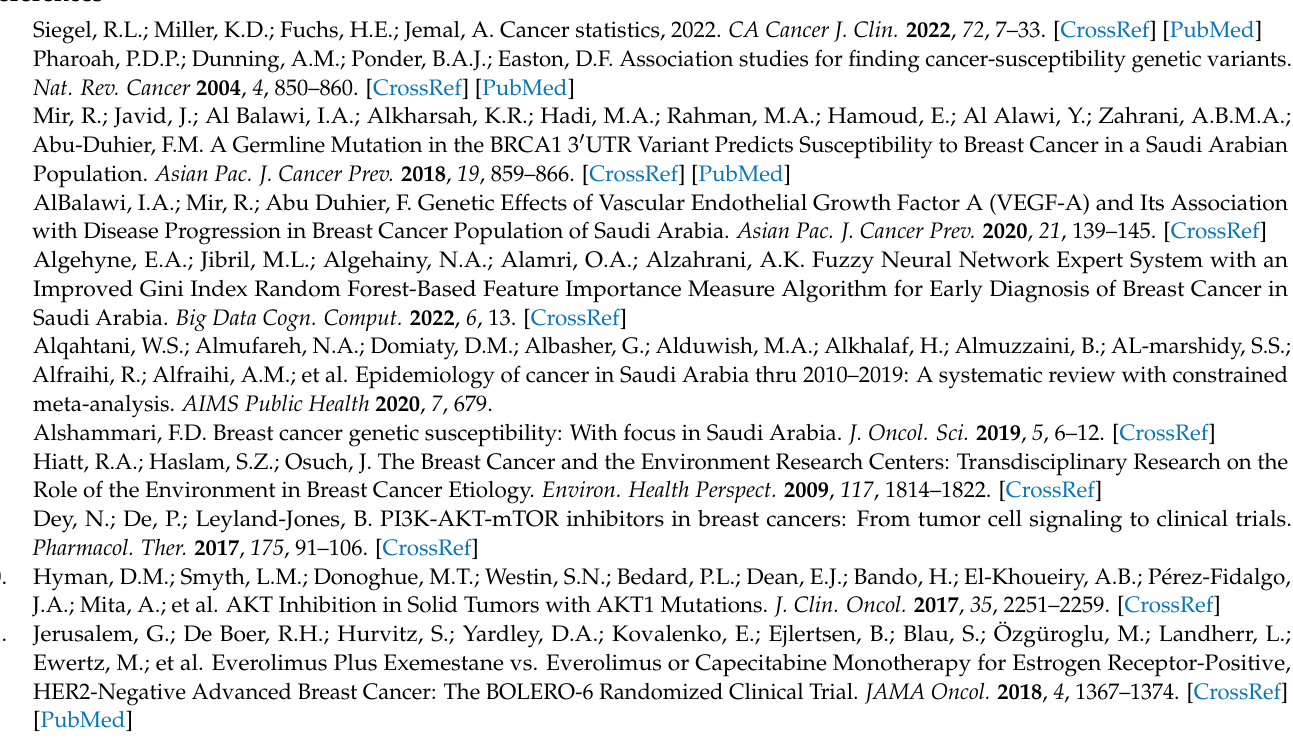
WES; Table S2: BRCA2 GENE VARIENTS OBTAINED FROM WES; Table S3: KLF14 gene varients; Figure S1: AKT-1 rs1130233 G > A gen otyping by ARMS-PCR of in Breast cancer patients; Figure S2: Phosphatidylinositol 3-kinase(PI3K)rs121913281 C > T genotyping by ARMS-PCR; Figure S3: MDM4 rs11801299 A > G genotvping by ARMS-PCR of in Breast cancer patients; Figure S4: MiR-27a rs895819 A > G genotyping by ARMS-PCR of in Breast cancer patients; Figure S5: MiR-196a2 rs11614913 C > T genotyping by ARMS-PCR of in Breast cancer